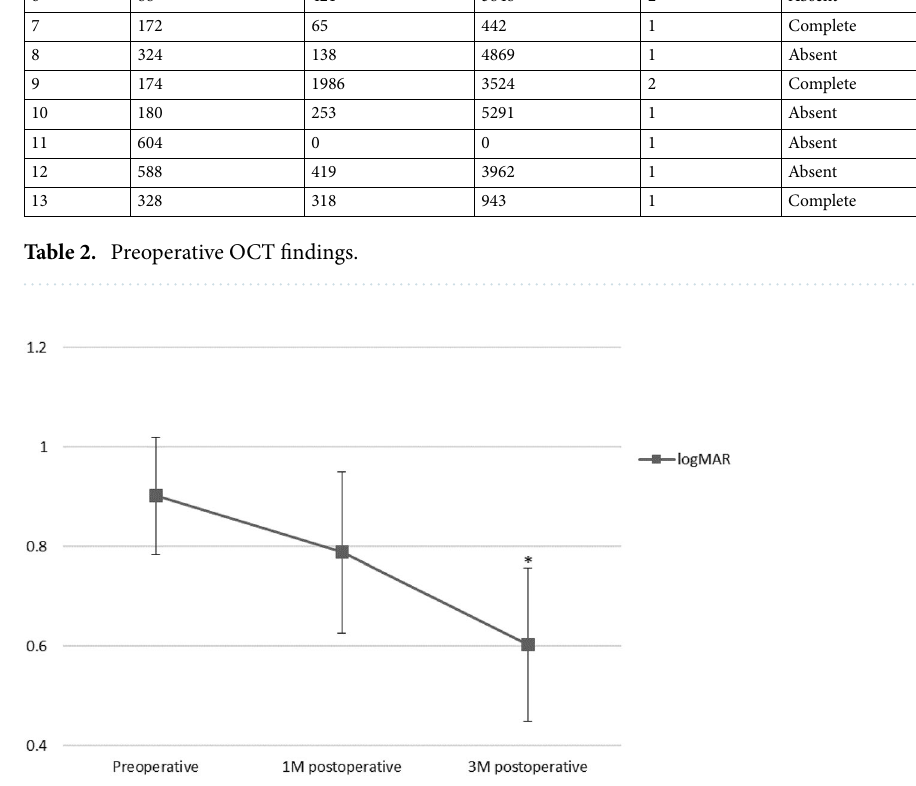
Figure 1. Mean BCVA of all patients. *P < 0.01.